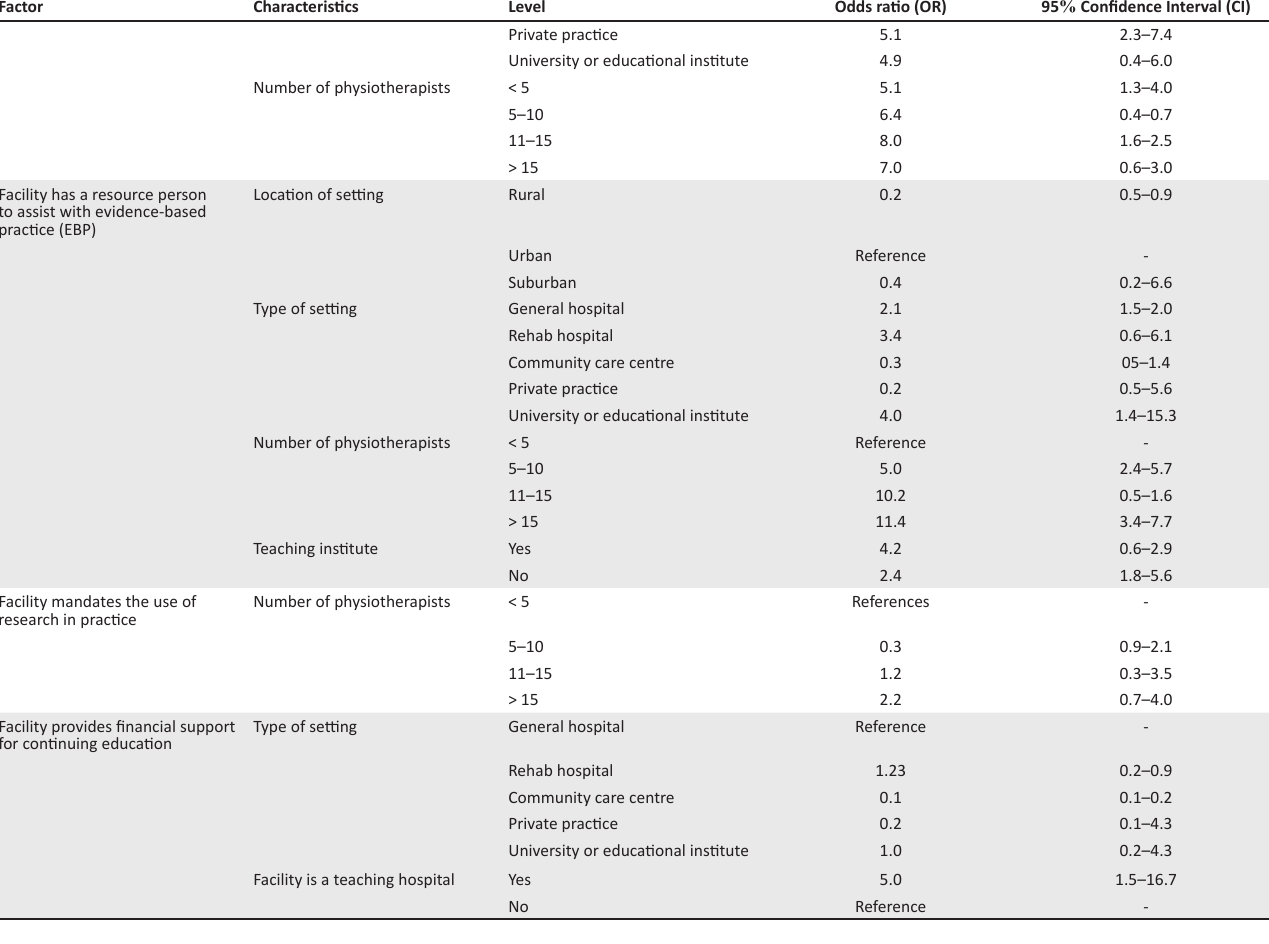
TABLE 5 (Continues...): Relationship between organisational characteristics and organisational factors and evidence-based physiotherapy practice. Factor